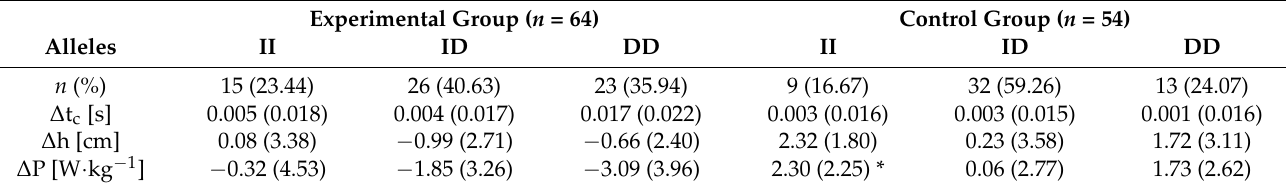
Table 3. Effect of ACE gene on supercompensation effect in